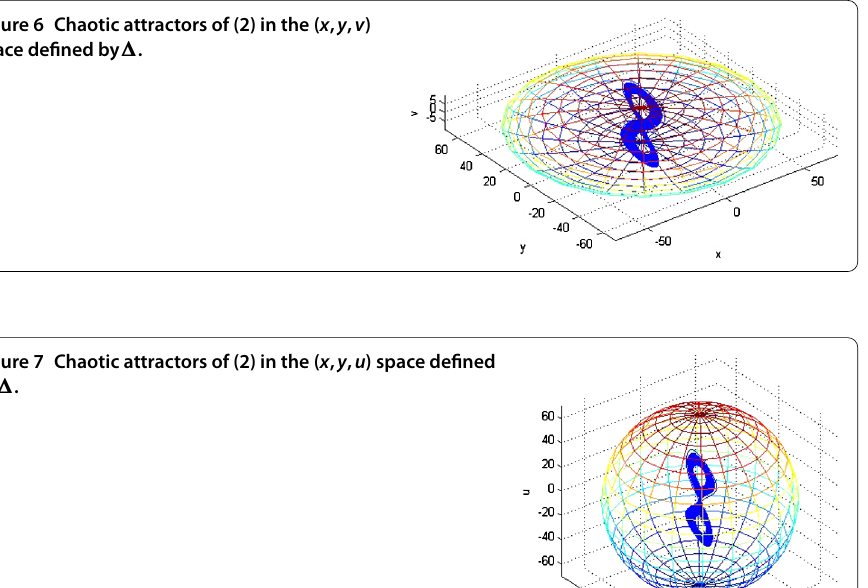
Figure 6 Chaotic attractors of (2) in the ( x , y , v ) space defined by (cid:2) .